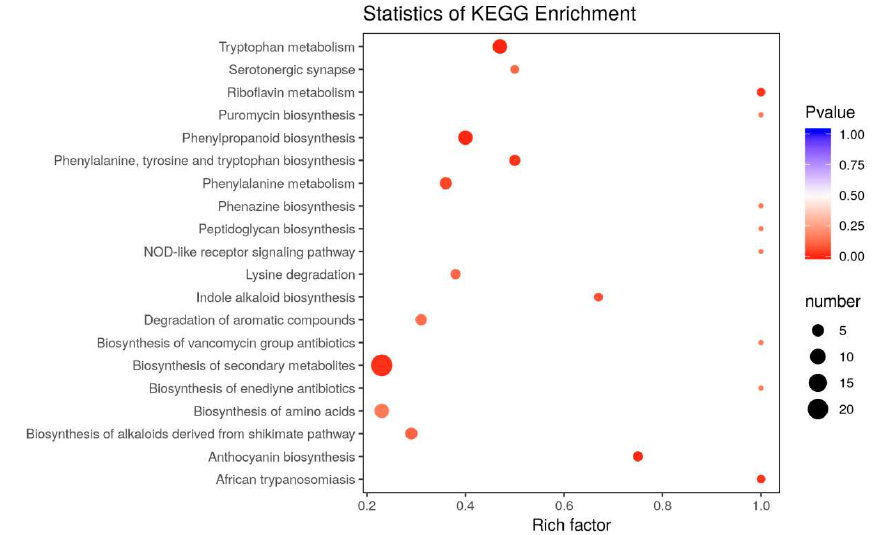
Figure 7. Top 20 enriched Kyoto Encyclopedia of Genes and Genomes (KEGGs) among the annotated differential metabolite. The X -axis represents the enrichment factor corresponding to each pathway, the Y -axis indicates the KEGG pathway. The color of the spot corresponds to different p-value ranges and the size of the spot represents the number of different metabolites enriched. A p-value less than 0.05 was significantly enriched.